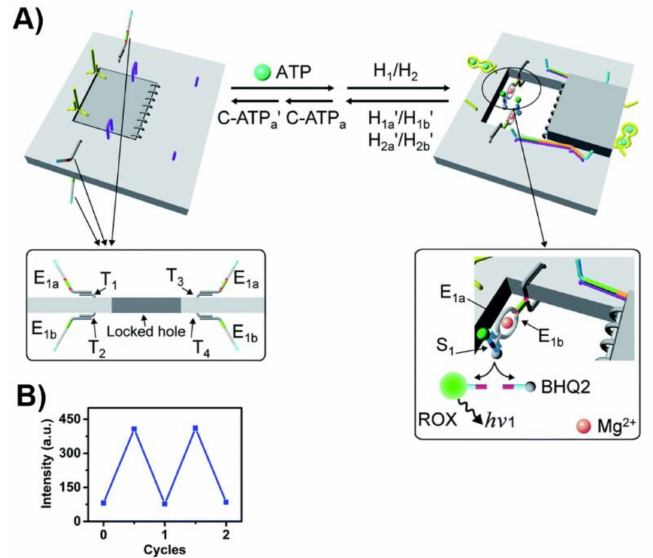
Figure 19. ( A ) ATP-driven opening and closure of a “window” in an origami scaffold and the triggered “ON”/”OFF” activation of the Mg 2+ -ion-dependent DNAzyme in the structurally confined cavity. Two subunits of the DNAzyme are positioned at the top and below the origami scaffold. Opening of the “window” leads to the self-assembly of the Mg 2+- ion-dependent DNAzyme in the cavity resulting in the activation of the DNAzyme and the cleavage of the fluorophore/quencher- modified substrate. The fluorescence of the fragmented product transduces the activity of the DNAzyme. The closure of the “window” separates the two DNAzyme subunits leading to the switched off state of the DNAzyme. ( B ) Cyclic and switchable activation of the Mg 2+ -ion dependent DNAzyme in the cavity upon the switchable opening/closure of “window”. Reproduced with permission from ref. [217]. Copyright 2020 Royal Society of